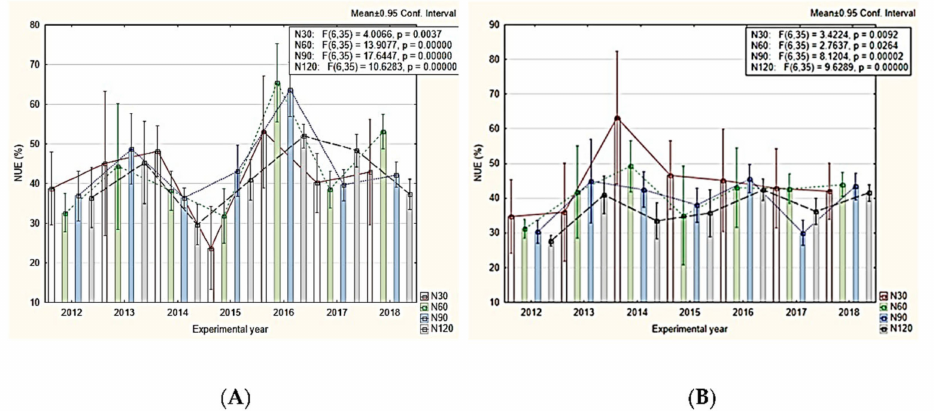
Figure 3. Main scenarios in NUE (reproduced after Vidican et al. [8] under the CC BY license). ( A ) wheat after maize and ( B ) wheat after soybean; N30, 60, 90 and 120 fertilization treatments with nitrogen (30, 60, 90 and 120 kg N ha − 1 y − 1 ). Means of six replicates: p values < 0.001 are highly significant from a statistical point of view (HS, confidence